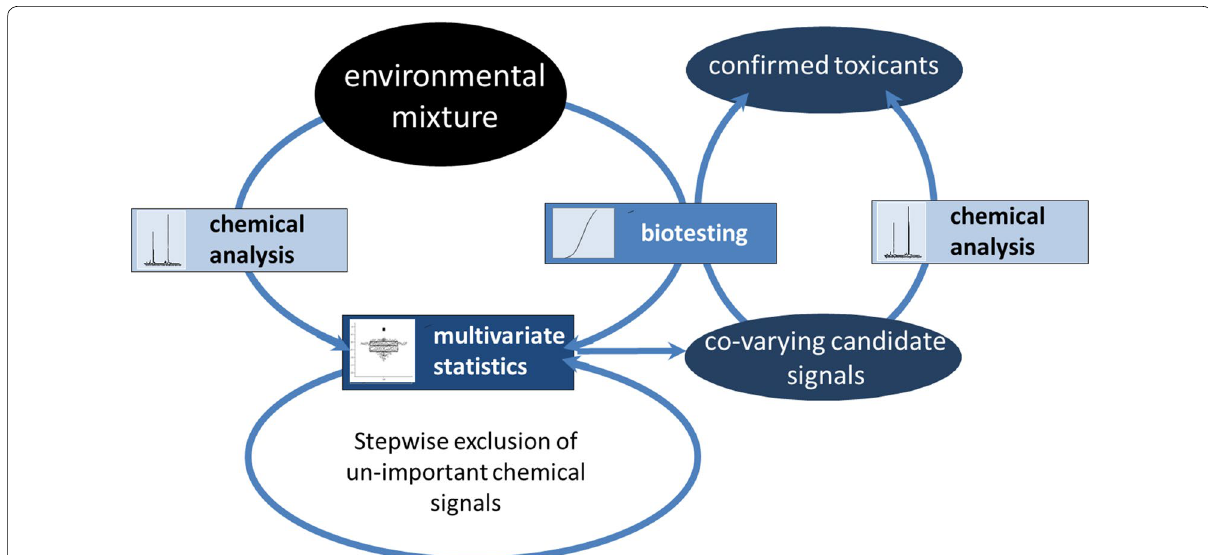
Fig. 3 Workflow for virtual effect‑directed analysis to reduce mixture complexity and to identify candidates that emerge from multi‑site data correlation analysis (Adapted from Brack et al. [9], with reprint permission from the